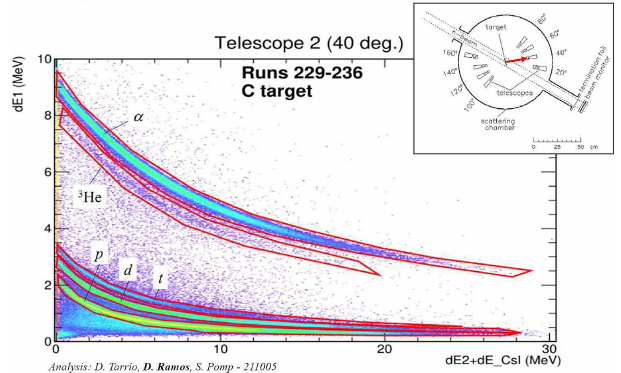
Fig. 6. Preliminary particle identification of light charged par- ticles ( p, d, t , α , 3 He) from the LIONS experiment at NFS. (Courtesy: S. Pomp,